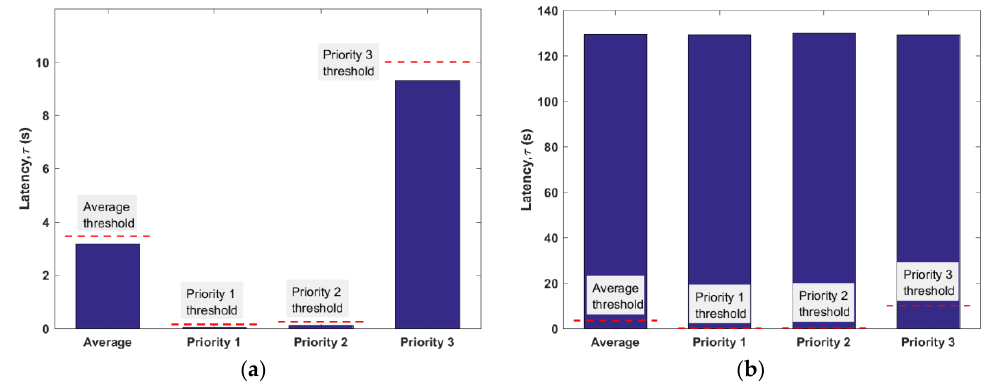
Figure 6. Latency for each protocol with λ = 1.25 packet per second, ( a ) OrMAC ( b ) DQCA. The dashed lines represent the permissible transmission delay given in Table 1.